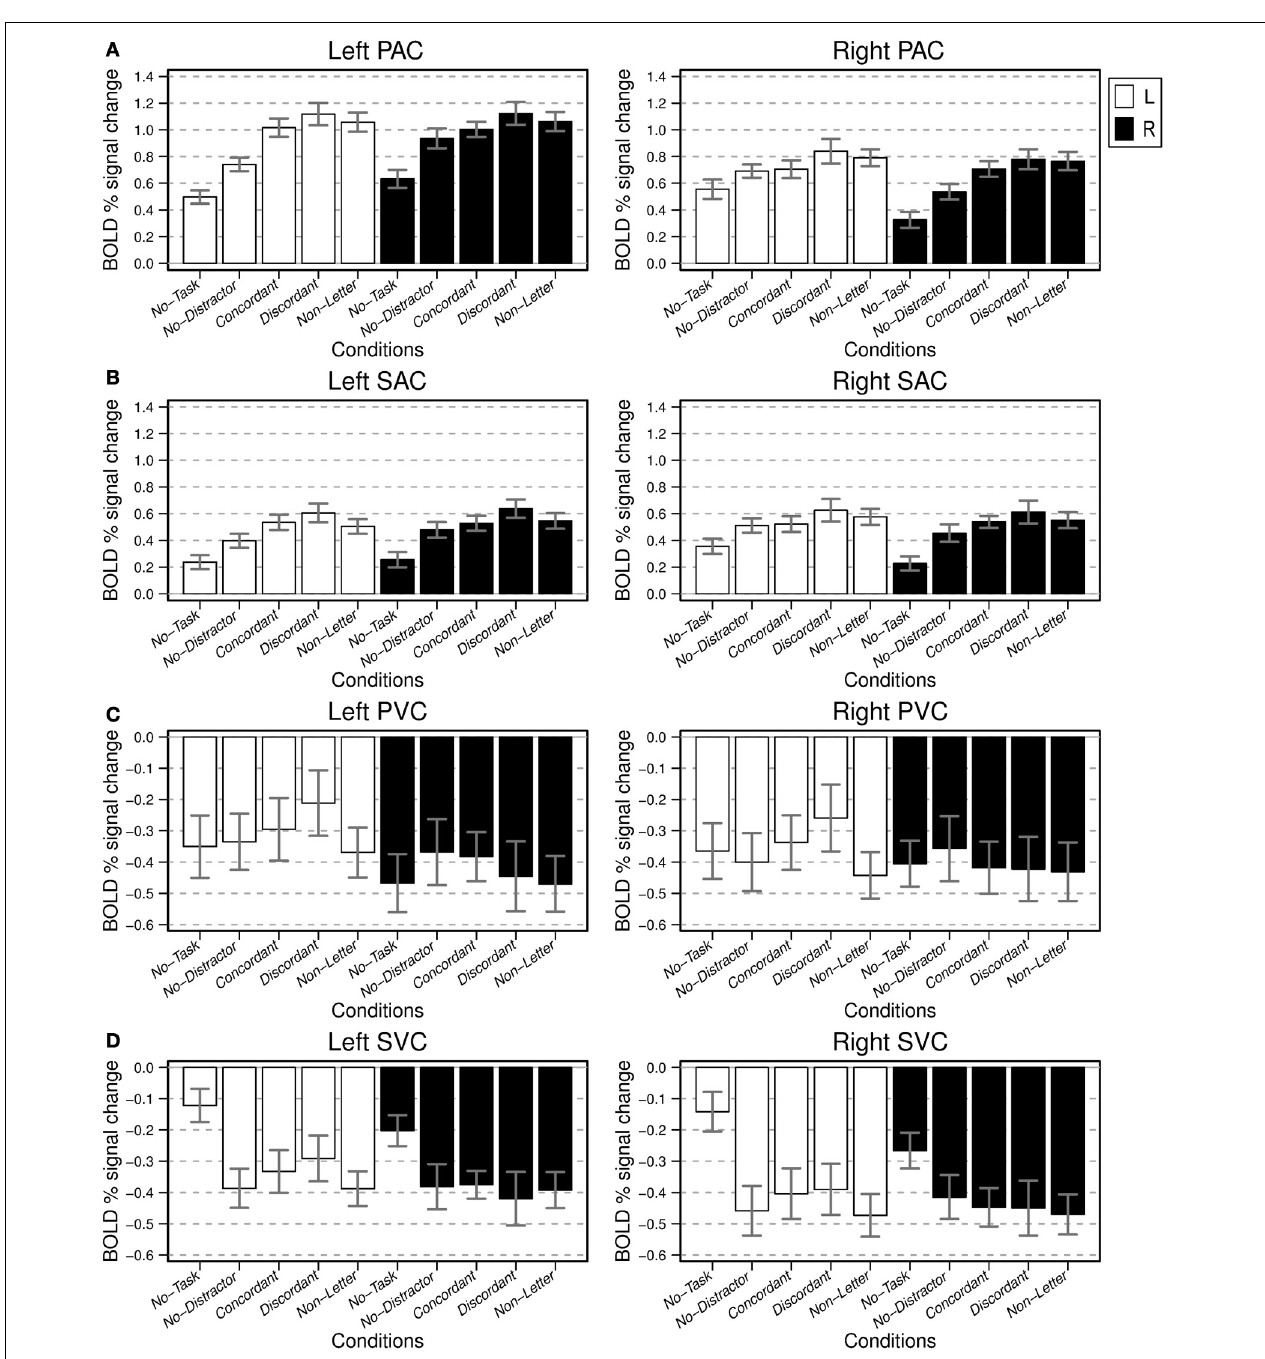
FIGURE 6 | BOLD percentage signal change relative to baseline for the considered sensory ROIs: PAC (A), SAC (B), PVC (C), and SVC (D). For each subject the mean fitted responses of all voxels, for each ROI, were determined. The bar plots present average ROI